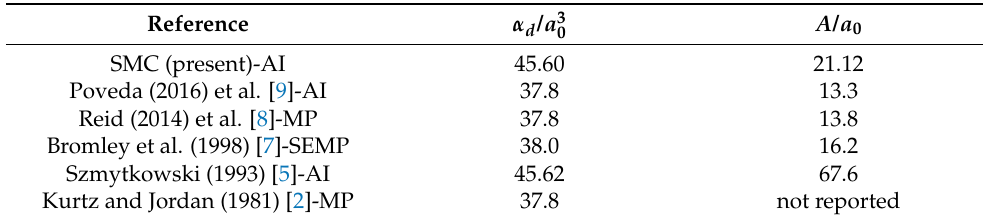
Figure 5. Elastic integral cross sections for positron–Be. Upper panel: cross sections as a function of α d given in a 3 . Bottom panel: this work compared to previous ones. (Refs. [2,5,7–9]). 0 Table 3. Scattering lengths A and dipole polarizabilities α d considered for positron–Be according to previous works. All values are in atomic